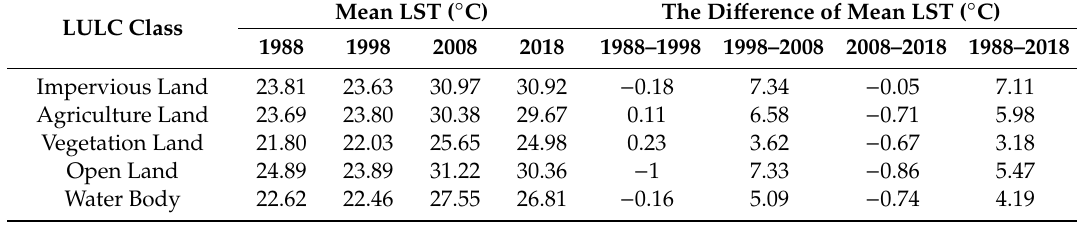
Table 3. Mean LST for different of LULC classes in Kathmandu Valley during 1988–2018. LULC Class Mean LST (°C) The Difference of Mean LST (°C)